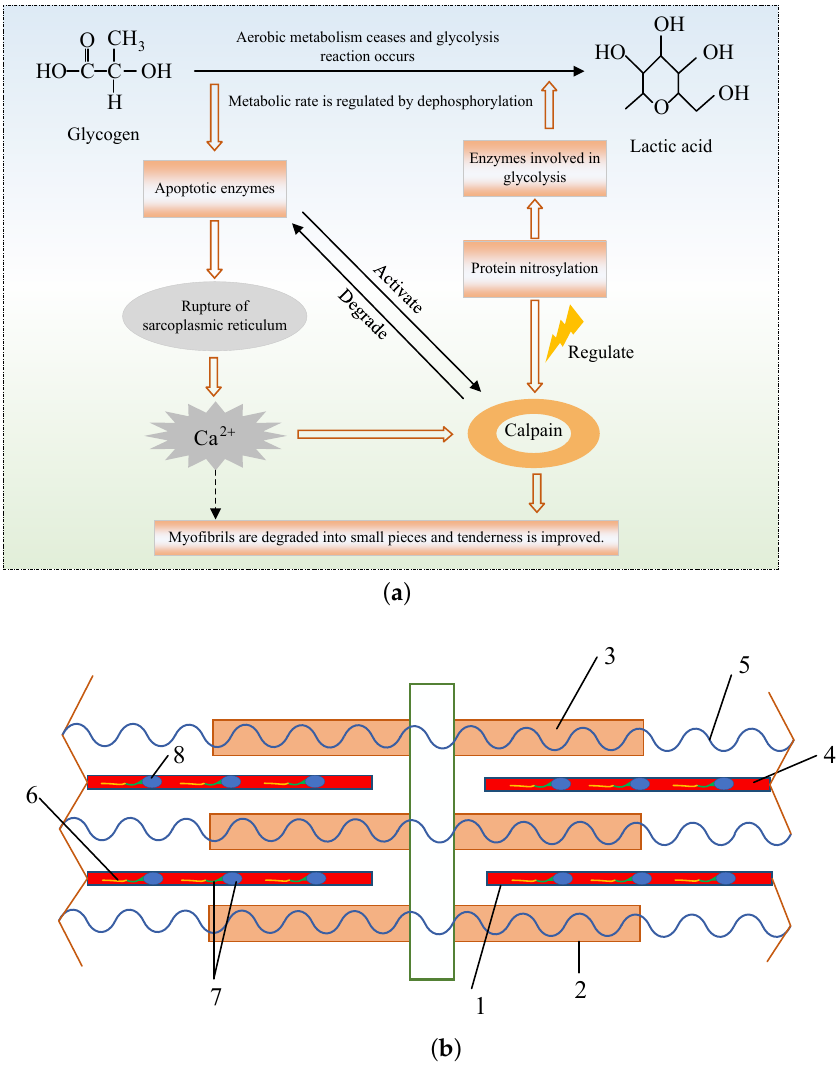
Figure 2. The role of calpains in meat tenderization and their effect on the structure of myofibrils [23]. ( a ) The mechanism of meat maturation involving calpains. ( b ) The structure of myofibrils (myofib- rillar protein related to postmortem maturation are marked separately: 1-thick myofilament; 2-thin myofilament; 3-myosin; 4-Actin; 5-Titin; 6-Tropomyosin; 7-Troponin complex; 8-Troponin. Table 1. Partial characteristics of the common lysosome cathepsins existing in animal muscles